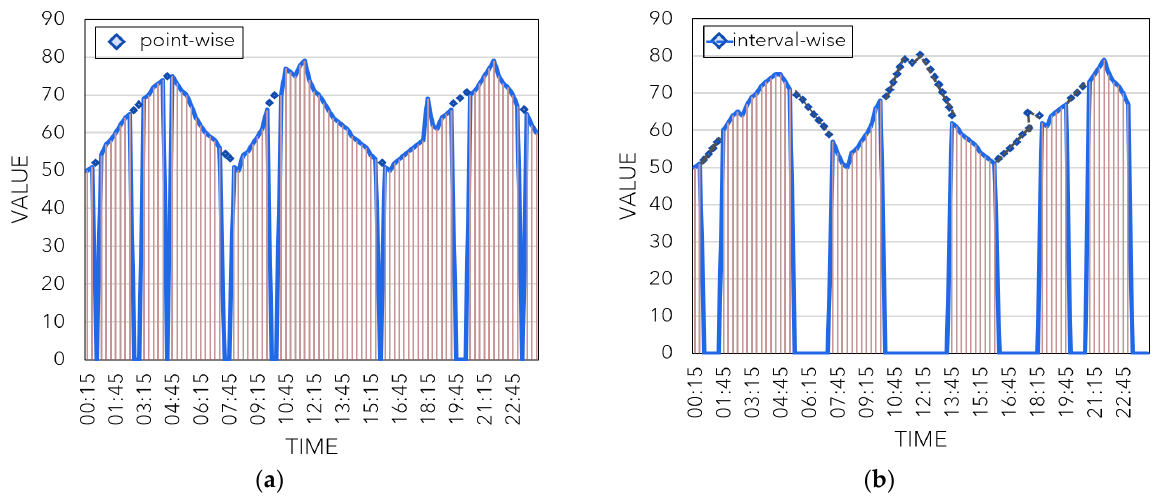
Figure 3. Illustration of ( a ) point-wise missing data and ( b ) interval-wise missing data.